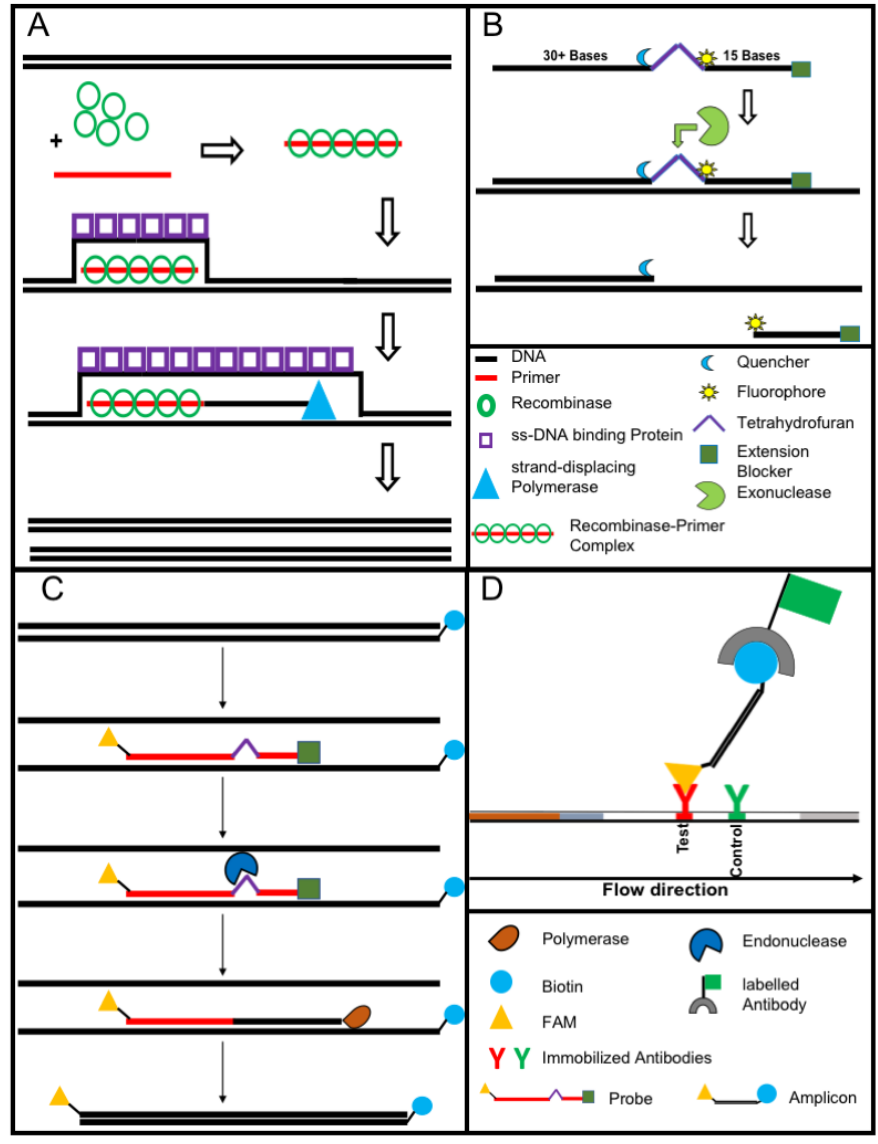
Figure 3. The recombinase polymerase amplification ( A ) employs a recombinase enzyme, a single-stranded binding protein, a strand-displacing (ss-DNA) polymerase, and a pair of target-specific primers. The primers form together with the recombinase enzyme the recombinase—primer complex which allows them to invade the double-stranded helix of the target DNA at the respective recognition site. The strand-displacing polymerase elongates the primers while the ss-DNA binding protein stabilizes the displaced strand in order to prevent self-annealing and ejection of the primers by branch migration. Real-time detection of amplification ( B ) is achieved by a sequence specific probe consisting out of a tetrahydrofuran abasic–site mimic (THF) flanked by fluorophore and quencher-labelled nucleotides as well as an extension blocker at the 3´ end. As the probe pairs with the complimentary sequence, a double-strand specific exonuclease slices the THF and the fluorophore is dissociated resulting in a signal [24] . Detection of RPA amplicon is in a lateral flow format ( C , D ). The use of a 5`end Biotin-labelled reverse primer in the RPA reaction leads to an antigenic-tagged reverse strand. When the 5-Carboxyfluorescein (FAM)-labelled probe binds to the complimentary strand a double-strand specific endonuclease slices the THF. The extension blocker is released and the remaining oligonucleotide can act as primer resulting in a FAM- and biotin-labelled amplicon (C), which can be detected in a lateral flow sandwich format (D, [25] ).